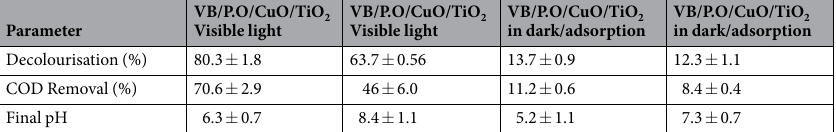
Table 4. Removal percentages for SBL post-treated with sequential treatments. After performing the photocatalytic treatment for 5 h on SBL previously treated with P. ostreatus , the COD removal was 80.3%, and the decolourisation percentage was 70.6%. For P. pastoris , photocatalytic treatment resulted in 63.7% COD removal and 40% decolourisation. The removal in the dark by composite adsorption (negative control) did not exceed 15% for either fungi. COD (chemical oxygen demand), VB (viable biomass), P.O ( Pleurotus ostreatus ), P.P ( Pichia pastoris